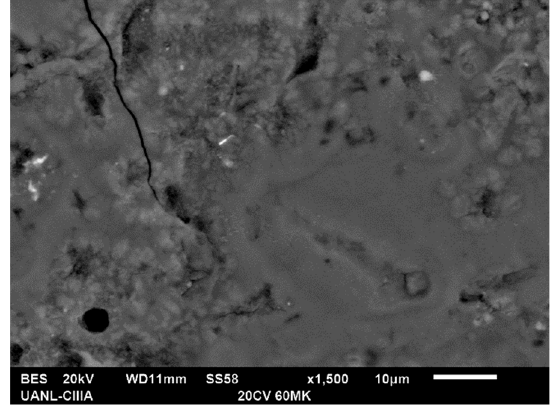
Figure 7. Cementitious matrix with high metakaolin content.